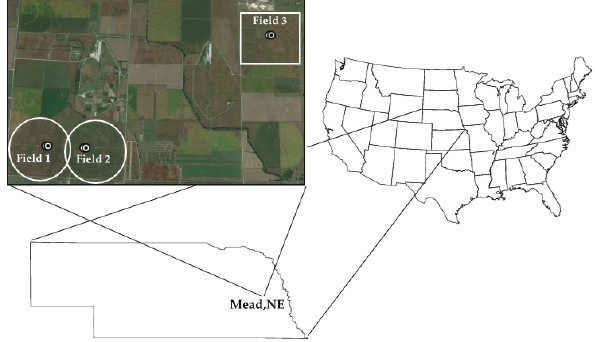
Figure 2. Location of the irrigated (lower left) and rain-fed (upper right) study fields. The white dots represent the locations of the mi- crometeorological